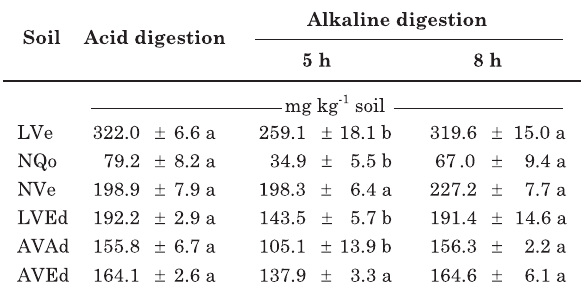
Table 5. Total S by acid and alkaline digestion,